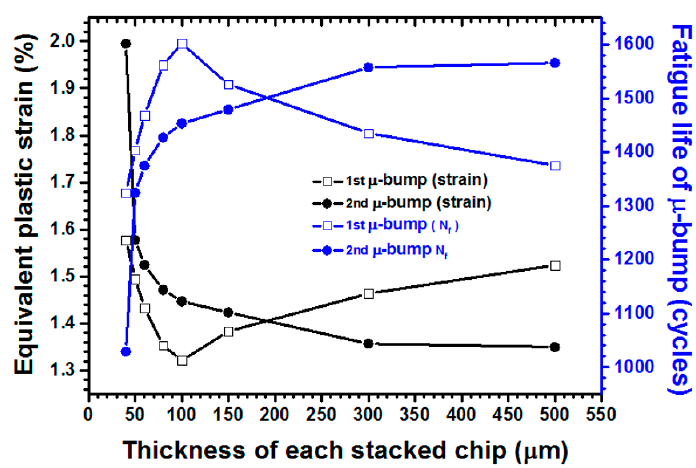
Figure 10. Curves of maximum equivalent plastic strain and predicted fatigue cycles for the outermost μ -bumps in the first and second layers of stacked chips versus various chip thicknesses.